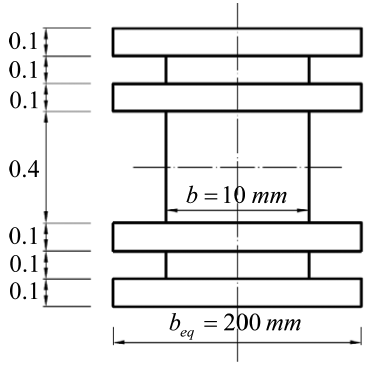
Fig. 7. Equivalent cross section of the composite